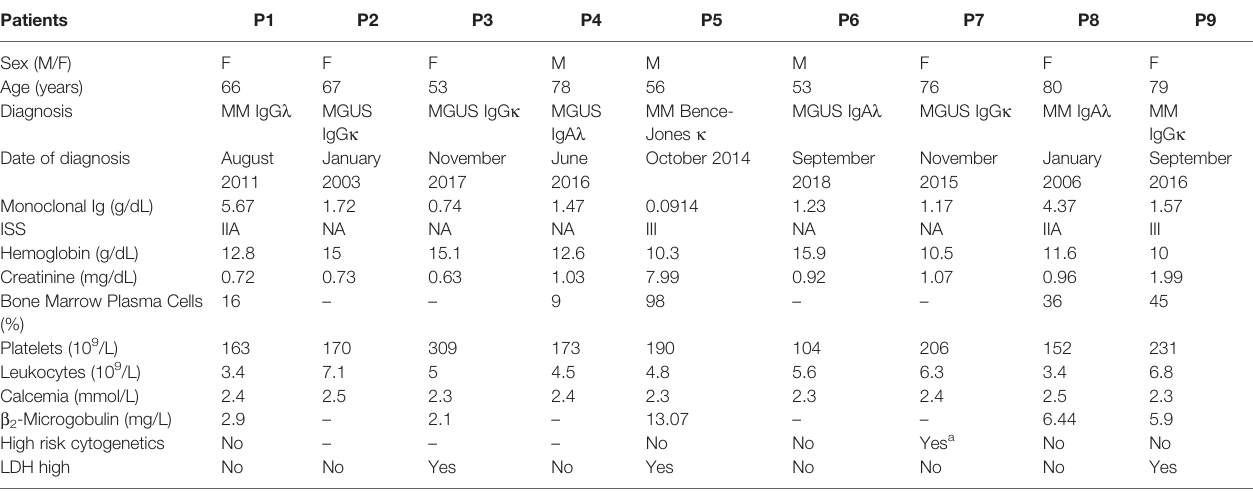
TABLE 1 | Main patient characteristics at diagnosis of the gammopathy disease.